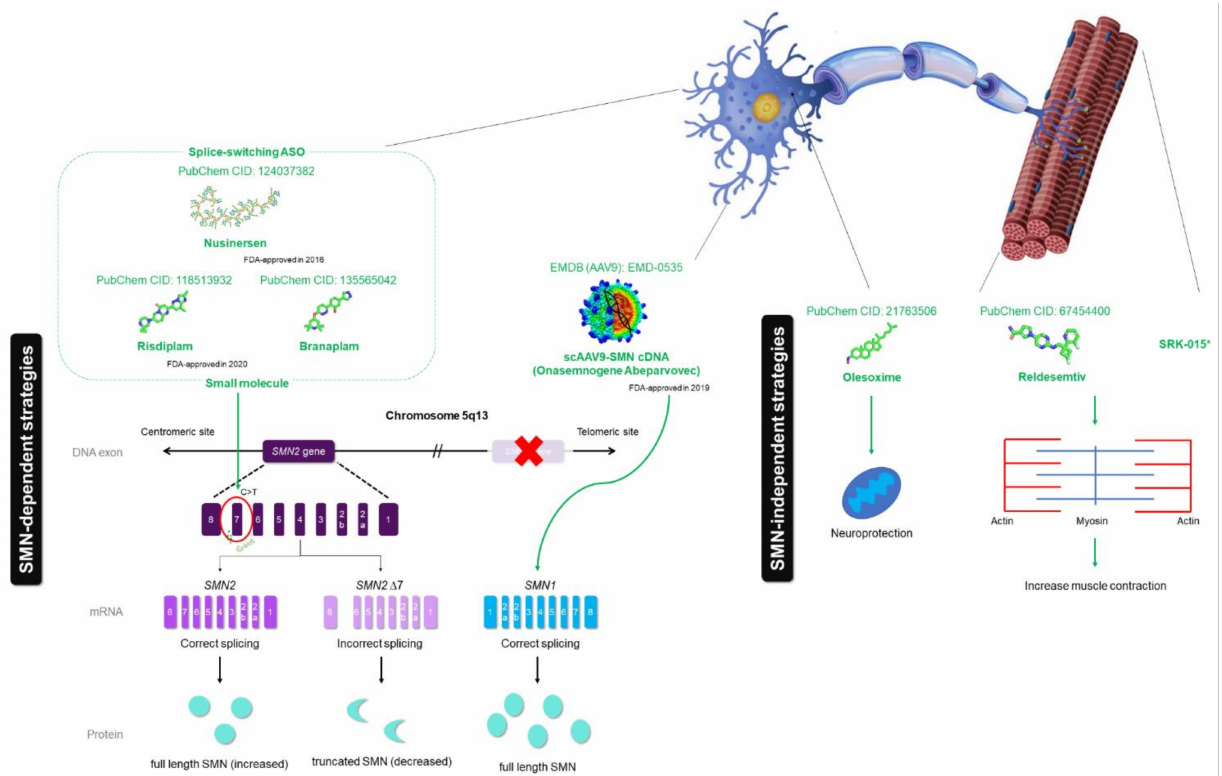
Figure 6. Therapeutic mechanism of SMA drugs, including three FDA-approved drugs (nusinersen, onasemnogene abeparvovec and the recent FDA-approved drug risdiplam) and drugs that are in clinical trials (branaplam, olesoxime, reldesemtiv and SRK-015). Nusinersen (PubChem CID: 124037382), a synthetic antisense oligonucleotide (ASO), is designed to hybridize intronic splicing silencer N1 (ISS-N1), which is heterogenous nuclear ribonucleoprotein (hnRNP) A1-dependent, to facilitate accurate splicing of SMN2 transcripts. Onasemnogene abeparvovec (no available structure) is a gene therapy that targets the SMN1 gene replacement using adenovirus vector AAV9 (EMDB: EMD-0535). Risdiplam (PubChem CID: 118513932) and branaplam (PubChem CID: 135565042) are small molecules that have the same mechanism of action as nusinersen. The red ‘X’ mark represents the deleted SMN1 gene. Other than SMN-dependent drugs, olesoxime (PubChem CID: 21763506) acts as neuroprotective compound, while reldesemtiv (PubChem CID: 67454400) and SRK-015 act as a fast skeletal muscle troponin activator (FSTA) and myostatin inhibitor, respectively, to increase the muscle